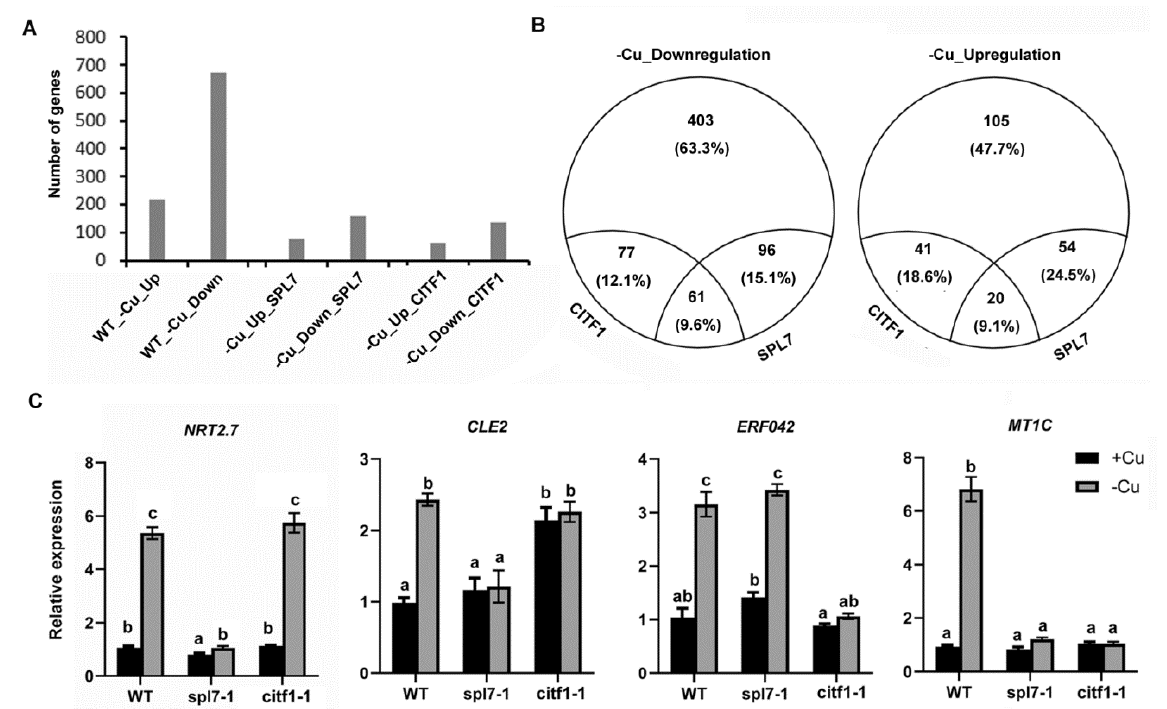
Figure 5. Effects of CITF1 and SPL7 on the expression of Cu deficiency responsive genes. ( A ) Genes responding transcriptionally to Cu deficiency. WT_ − Cu_Up, genes upregulated by − Cu in wild type; WT_ − Cu_Down, genes genes downregulated by − Cu in wild type; − Cu_Up_SPL7, genes upregulated dependently of SPL7; − Cu_Down_SPL7, genes downregulated dependently of SPL7; − Cu_Up_CITF1, genes upregulated dependently of CITF1; − Cu_Down_CITF1, genes downregulated dependently of CITF1. ( B ) Pie chart indicating percentages of coregulation by CITF1 and SPL7. ( C ) Validation of some differentially expressed genes. Seedlings were grown on +Cu or − Cu medium for 7 days. Roots were used for RNA extraction. Data represent means ± SD ( n = 3). Different letters above each bar indicate statistically significant differences (ANOVA, p <